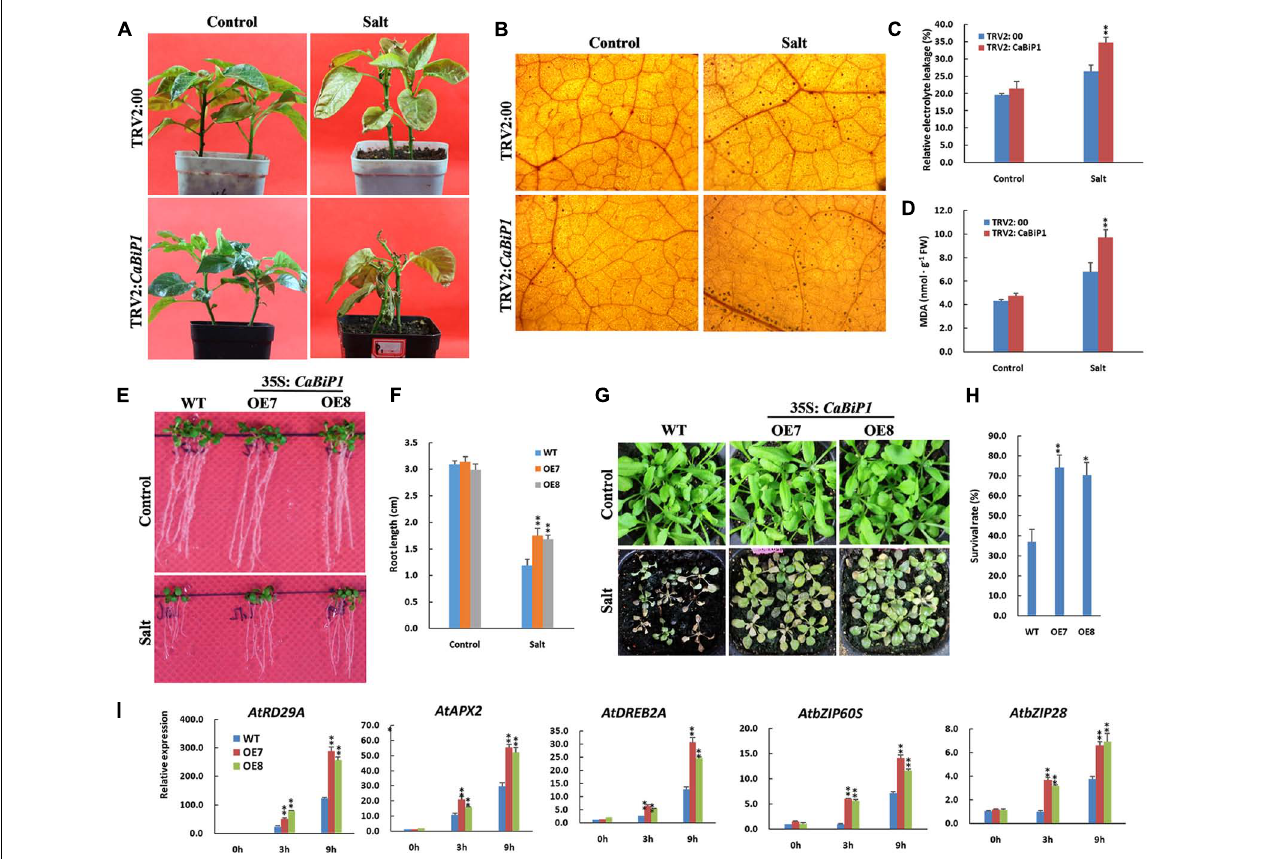
FIGURE 8 | Altered salt tolerance in CaBiP1 -silenced and CaBiP1 –overexpressing plants. (A) TRV2:00 and TRV2: CaBiP1 peppers seedlings irrigated with 300 mM NaCl solution for 14 days. (B–D) H 2 O 2 accumulation, REL and MDA content in pepper seedlings leaves treated with 300 mM NaCl solution for 24 h. (E,F) Root growth of WT and transgenic lines grown under 75 mM NaCl for 7 days. (G,H) Survival rate of 2-week-old Arabidopsis seedlings in soil treated with 300 mM NaCl for 15 days. (I) Expression of salt stress- and ER stress-related genes in leaves of 3-week-old WT and CaBiP1 -OE hydroponic seedlings treated with 300 mM NaCl s for the designed time duration. AtActin2 was used as the internal control gene. Data are the mean ± standard deviation from three biological replicates. Statistical significance is indicated by a single asterisk ( p < 0.05) and a double asterisk ( p < 0.01) based on the results of student’s t -test.